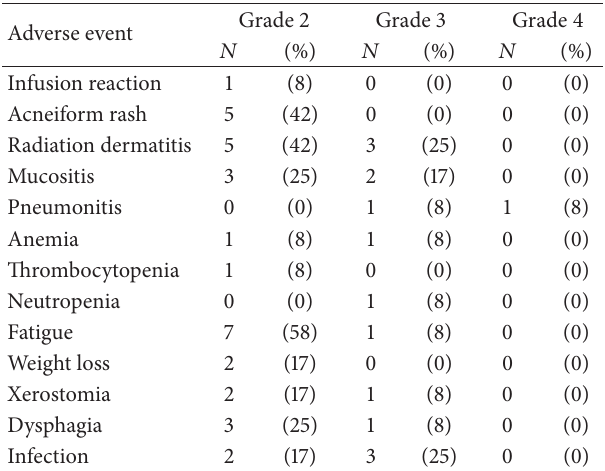
Table 3: Grades 2–4 adverse events occurring during cetuximab and radiotherapy classified according to the Common Terminology Criteria for Adverse Events, version 4.0; no grade 5 adverse events were observed.